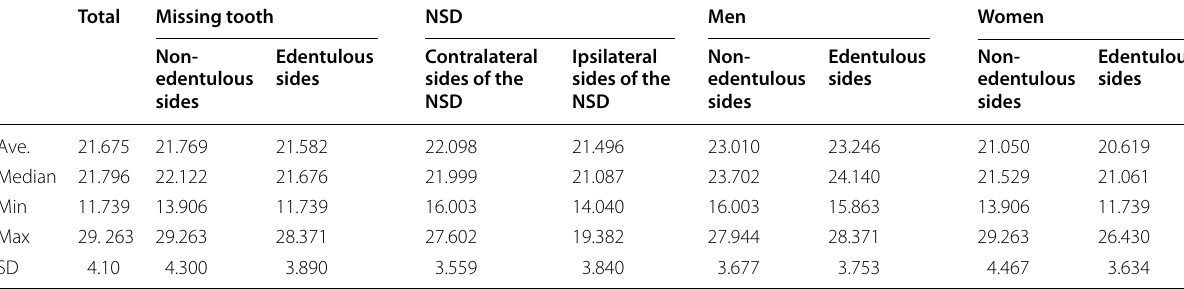
NSD nasal septal deviation, MSV maxillary sinus volume